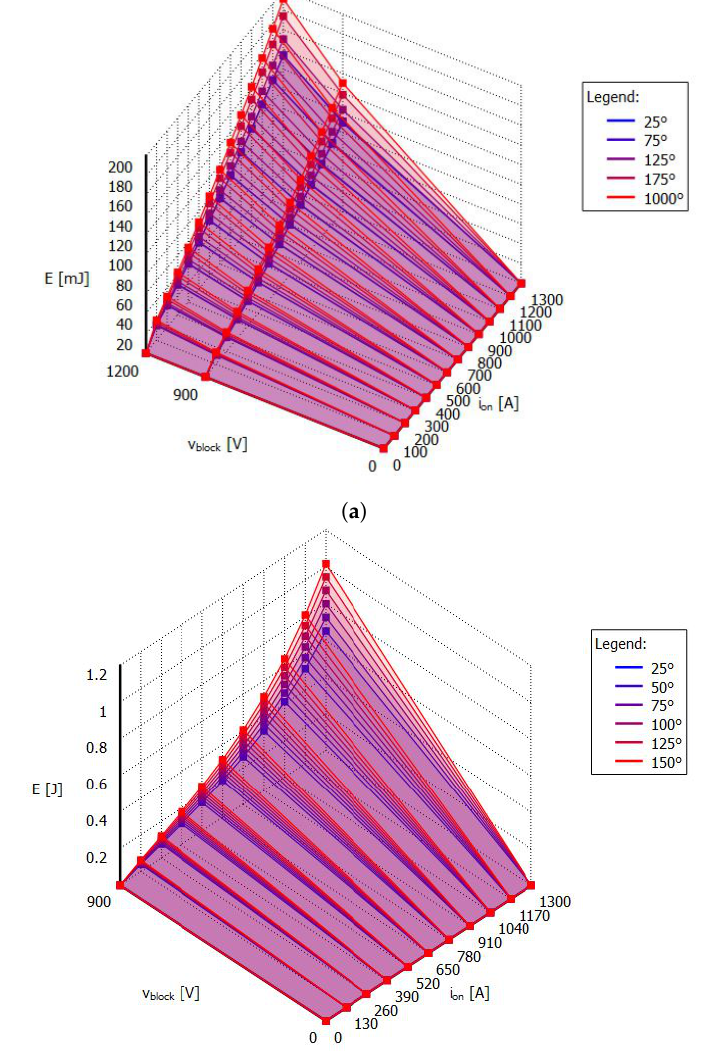
Figure 2. Example of module base-switching energies during the turn-on E base for different tempera- tures: ( a ) SiC-MOSFET, ( b )